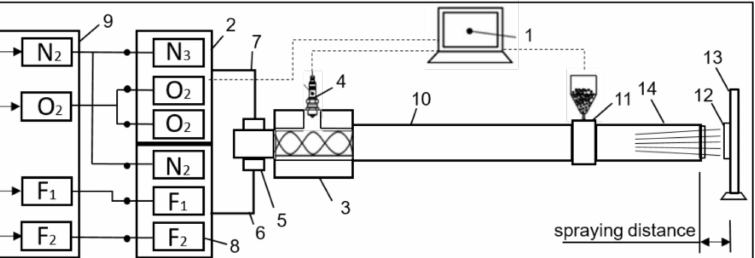
Figure 1. Schematic diagram of the CCDS2000 detonation complex: 1—control computer; 2—gas distributor; 3—mixing-ignition chamber; 4—spark plug; 5—barrel valve; 6—fuel line; 7—oxygen line; 8—gas valves; 9—gas supply unit; 10—indicated part of the barrel; 11—powder feeder; 12— workpiece; 13—manipulator; 14—the muzzle of the barrel; F 1 —acetylene; F 2 —propane–butane; O 2 —oxygen; N 2